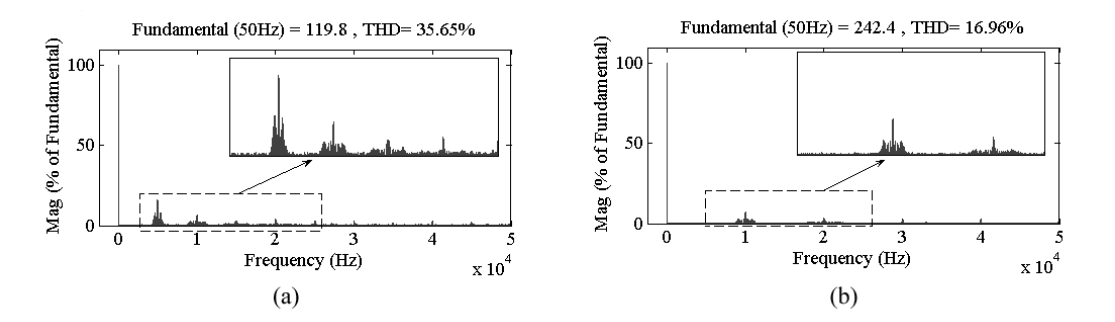
Figure 7. The fast fourier transform (FFT) analysis result of u AB . ( a ) The five-level simulation prototype; and ( b ) The nine-level simulation